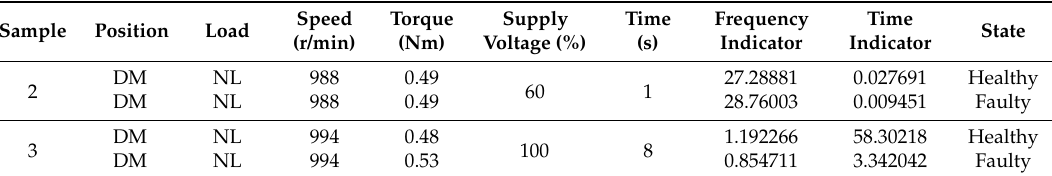
Table 15. Results of the time and frequency indicators for the DM